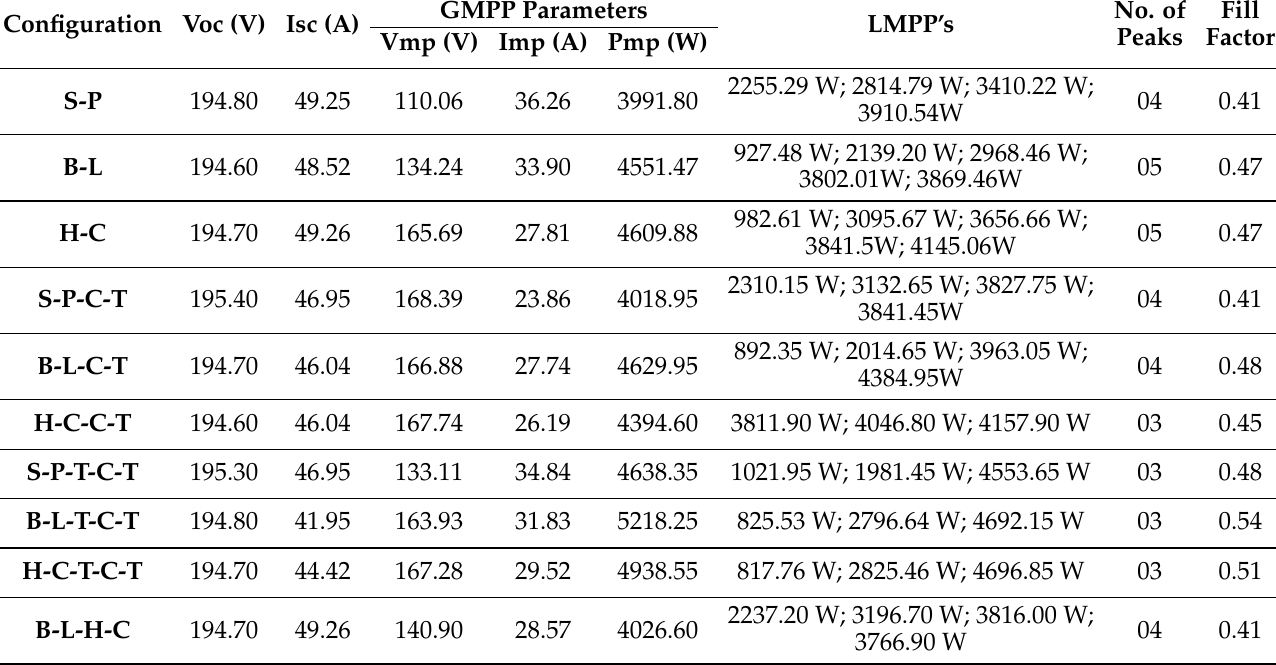
Table 9. Parameter variations of conventional and hybrid configurations under random